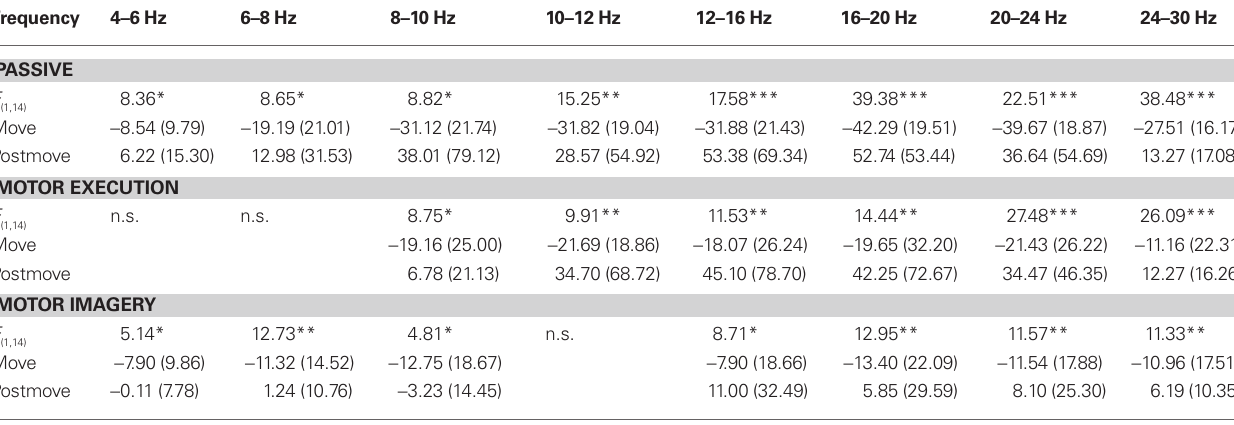
Table 2 | F -values, mean, and SD of erD/erS values for the significant main effect “phase.” Frequency